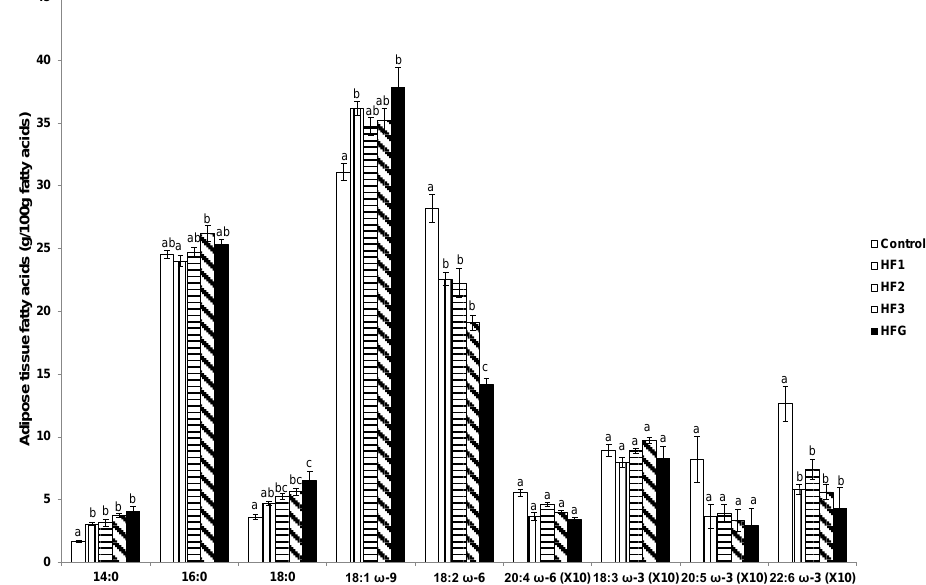
Figure 6. Adipose tissue fatty acids (g/100 g fatty acids). Numerals refer to the specific week of gestational high fat (HF) maintenance. G, gestation refers to HF maintenance throughout gestation. Values are means ± standard error of the mean (SEM). Different letters reflect significant changes.